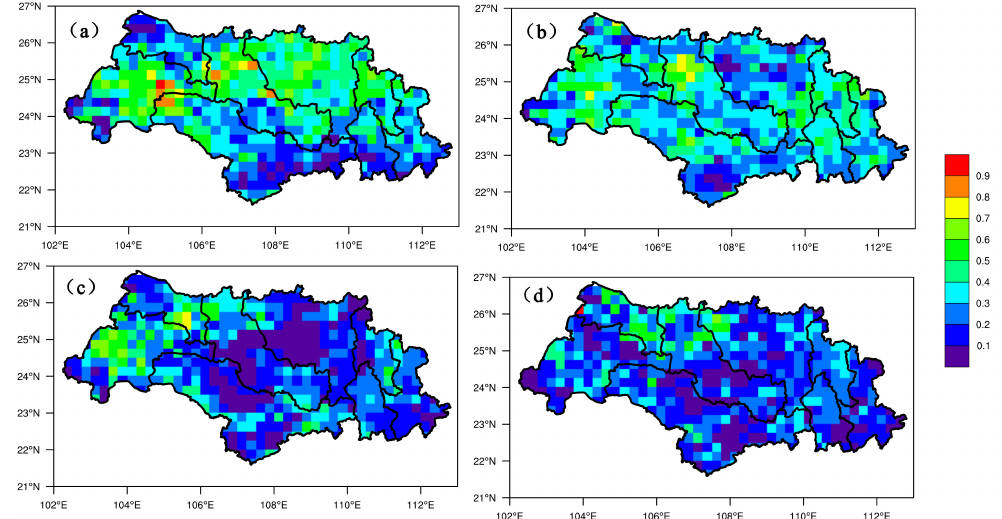
Figure 10. Study region maps showing the spatial distribution of CSI score ( ≥ 20 mm/day) in the Xijiang Basin. ( a ) 24 h lead time; ( b ) 48 h lead time; ( c ) 72 h lead time; ( d ) 96 h lead